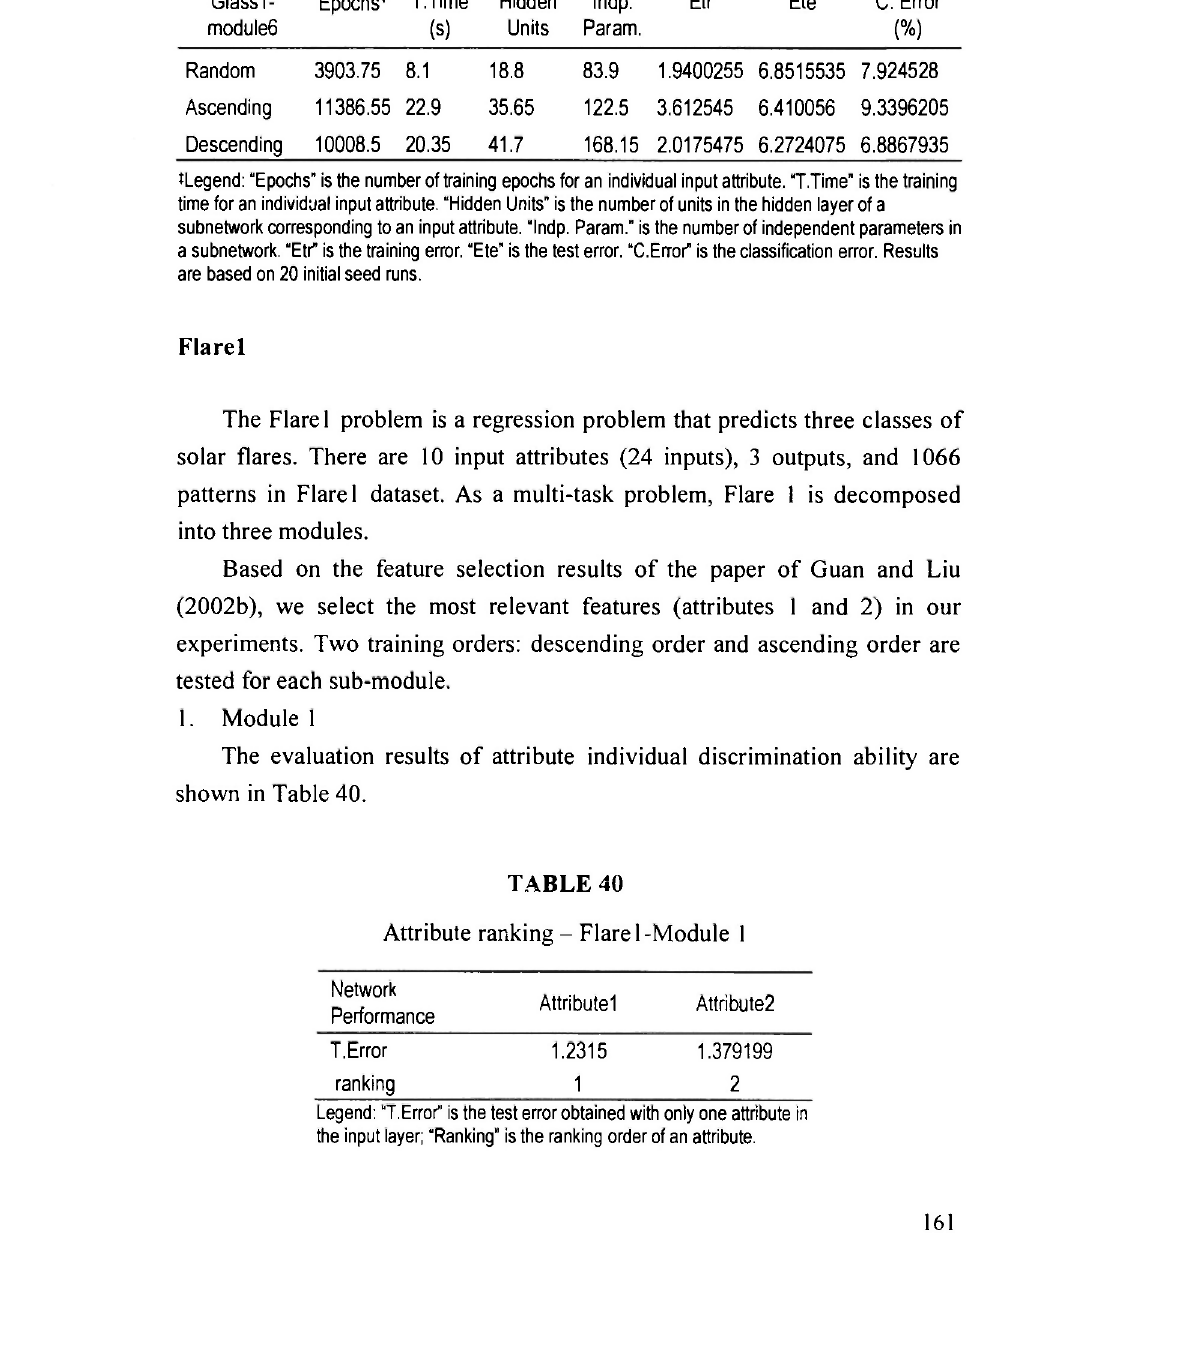
Comparison of ordered training - Glass 1-Module 6